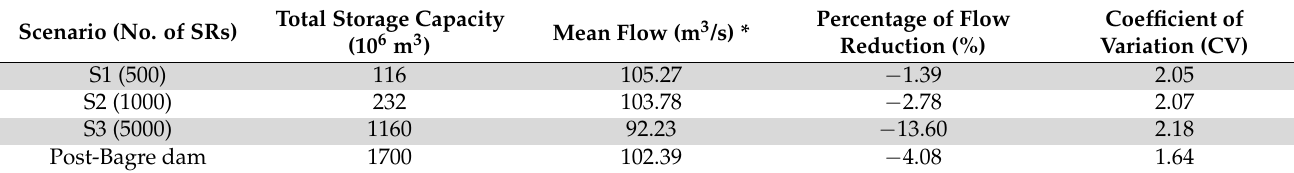
Table 8. Daily flow regime changes for different scenarios